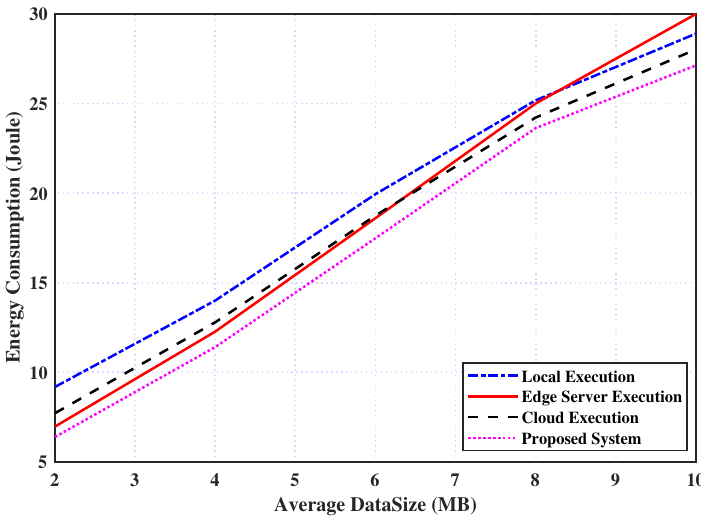
Figure 7. Latency comparison under different values of input data